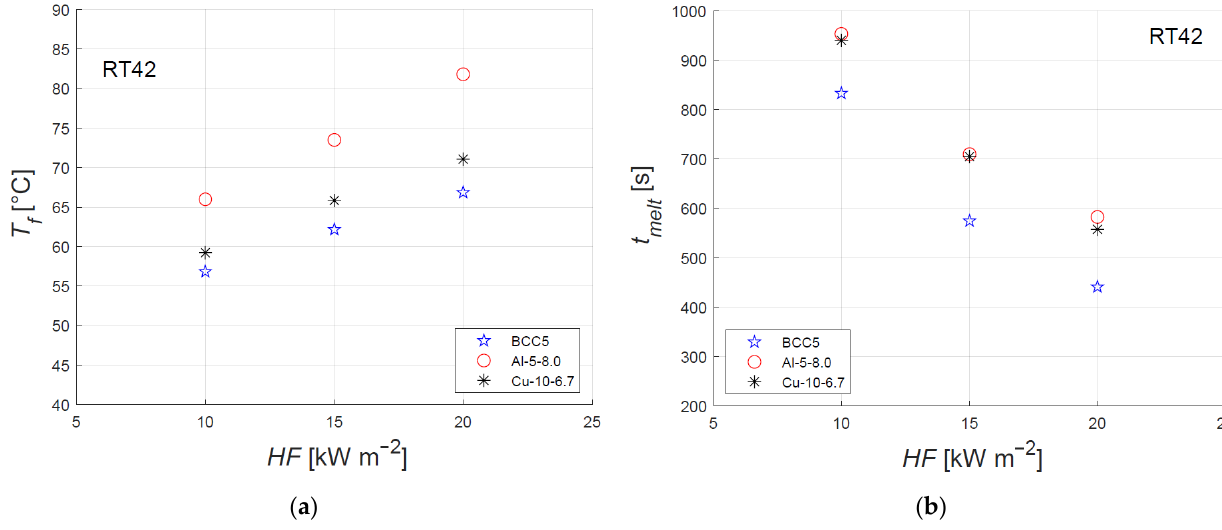
Figure 9. ( a ) Temperature reached by the heated side at the end of the melting process for different structures (case with RT42); ( b ) time needed to completely melt the paraffin for different structures (case with RT42).